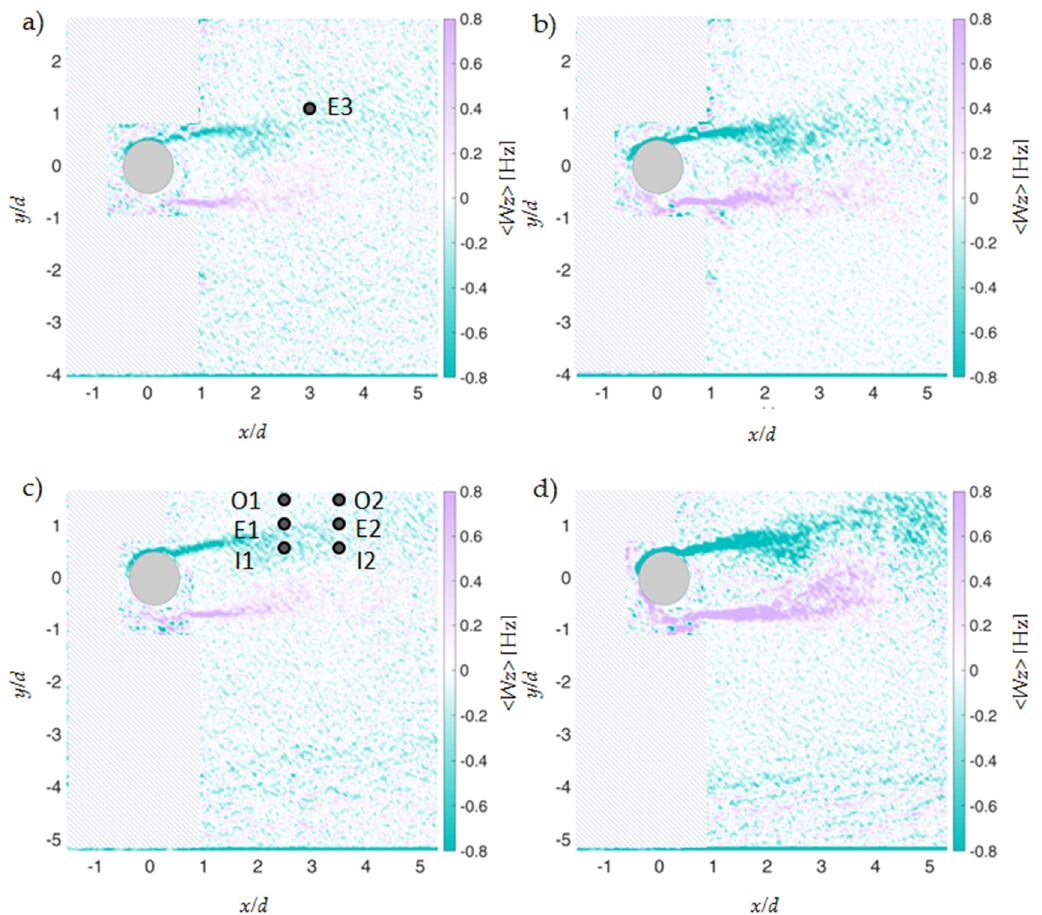
Figure 6. Horizontal maps of the ensemble-averaged vorticity <Wz> , at phases ( a ) W1 trough, ( b ) W1 crest, ( c ) W2 trough, ( d ) and W2 crest. Marked points identify the locations used for the successive wavelet analysis. Z axis is vertical and positive upward; here Z = 0.035 m.